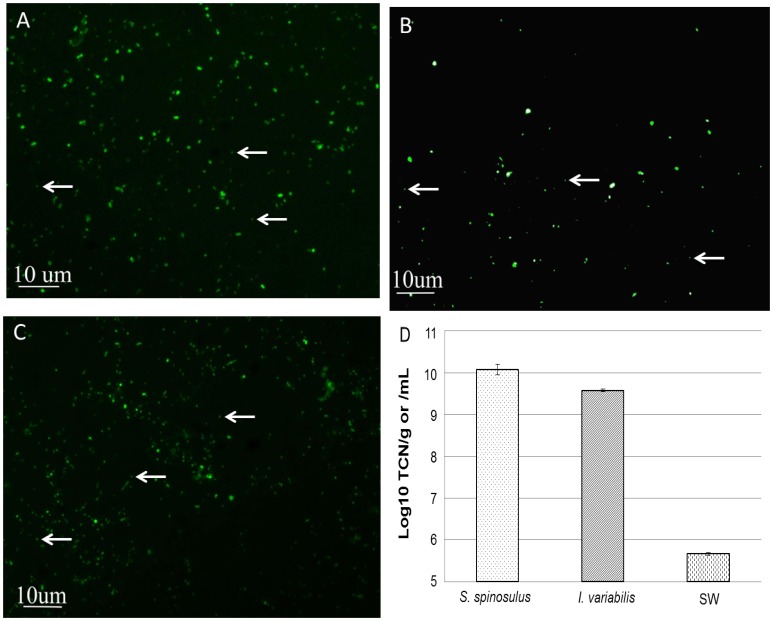
Epifluorescence counts.Microscopy pictures taken from S. spinosulus (A), I. variabilis (B) and Seawater (C) are shown. Arrows exemplify counted bacterial cells. Values in panel (D) are expressed as means ± standard errors of log-transformed total cell numbers (TCN).